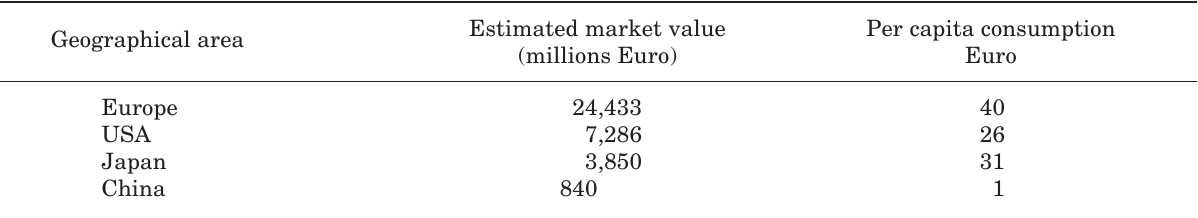
Table 1. Market value of cut flowers and plants and per capita consumption in selected countries. Values in Euros referred to 2002.